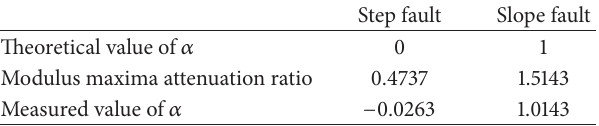
Table 1: Lipschitz exponent 𝛼